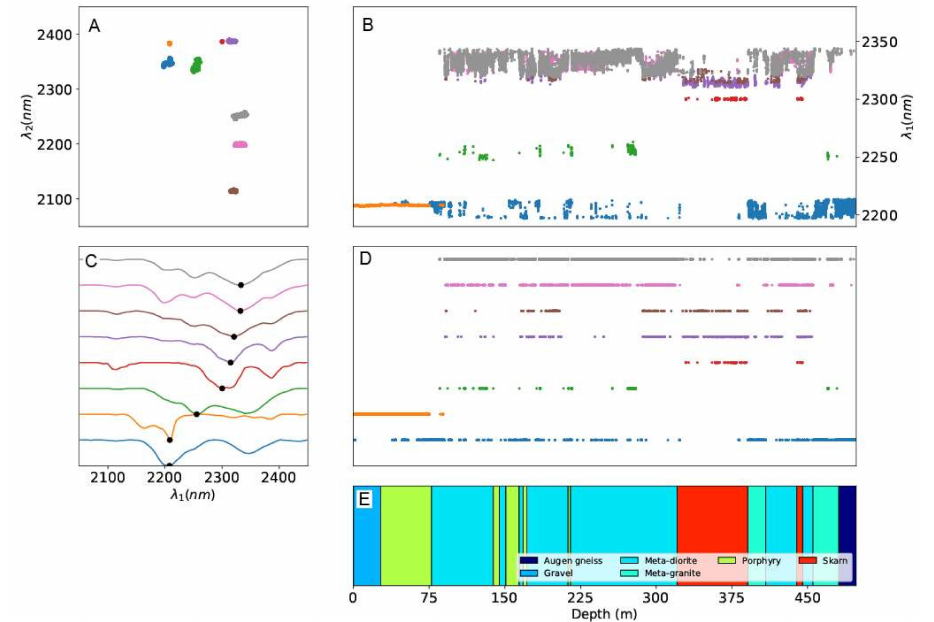
Figure 6. The 1st and 2nd deepest wavelength location of the extracted features in the 2050–2450 nm spectral region of the MSDP11 dataset ( A ), the down hole deepest feature as a function of hole depth ( B ). ( C ) shows the calculated MSR assemblages for each of the clusters in the top-left while the ( D ) plot shows the down hole distribution of those assemblages and ( E ) is the geologists logged litholgy. See the text included in the Results Section for a more detailed explanation of the individual